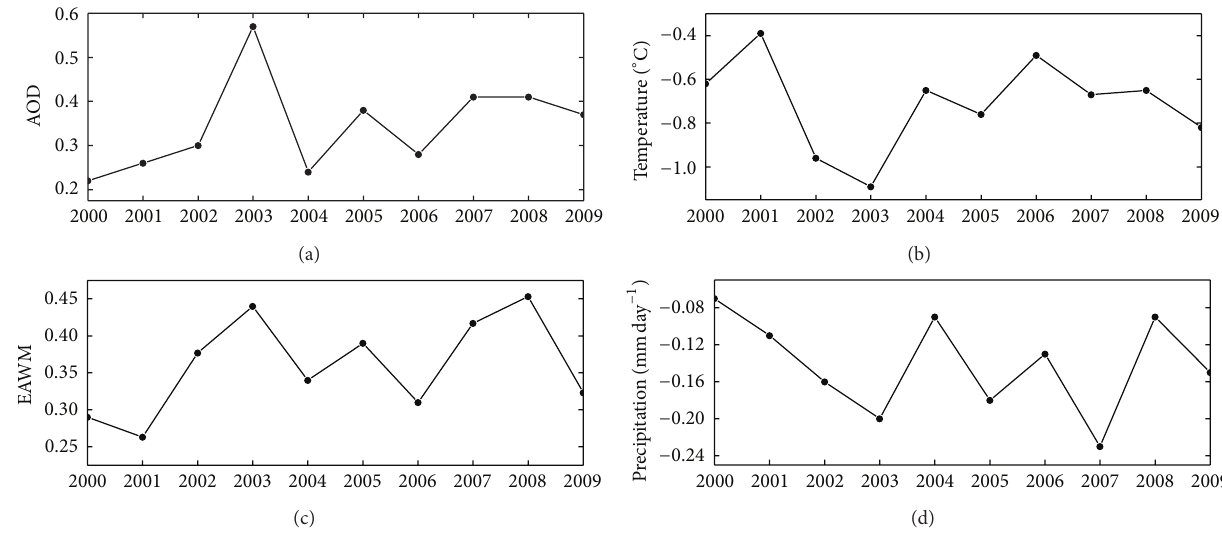
Figure 11: Year-to-year variations of winter dust AOD in the Taklamakan Desert in the Dust experiment (a), the difference in winter surface temperature in the Taklamakan Desert (b), the difference of EAWM index (c), and the difference in winter precipitation (d) in North China between Dust and Nodust experiments.